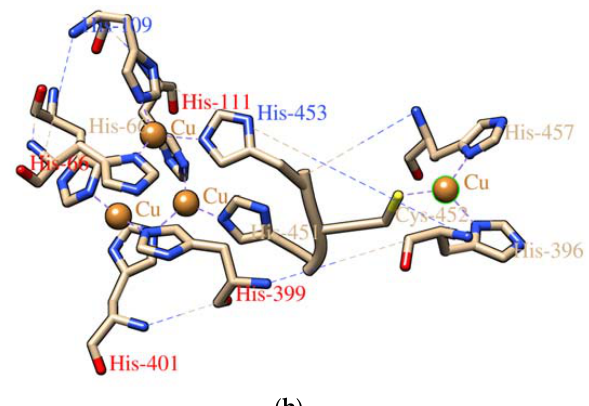
Figure 1. ( a ) 3D modelled structure of Trametes versicolor laccase [31] ( b ) and schematic representation of its copper coordination center [32].